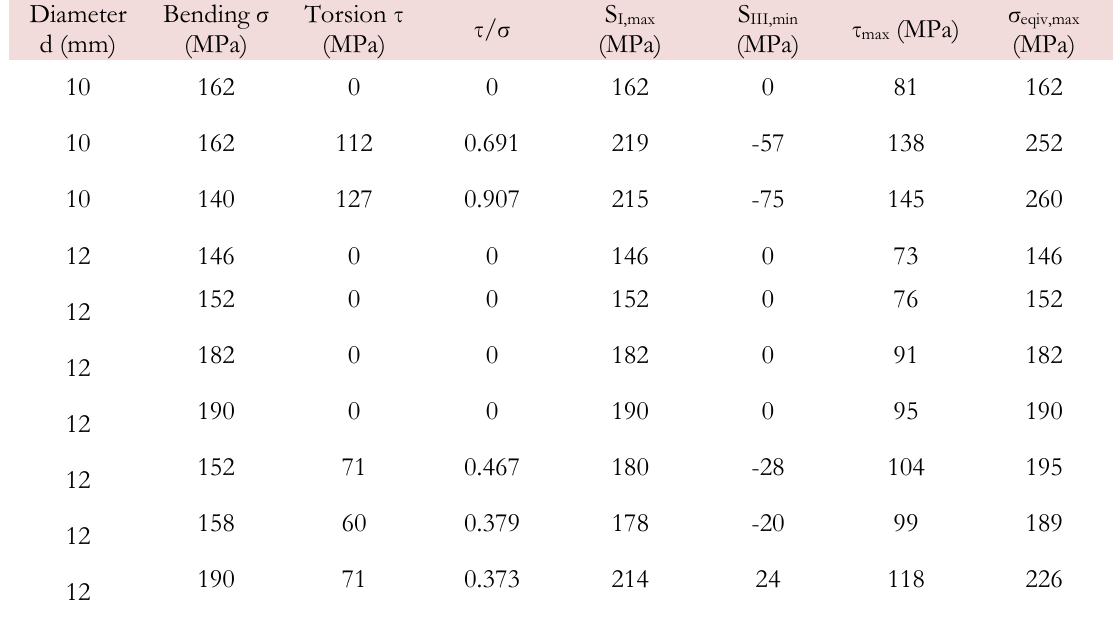
Table 3: Specimen dimensions and loading conditions.